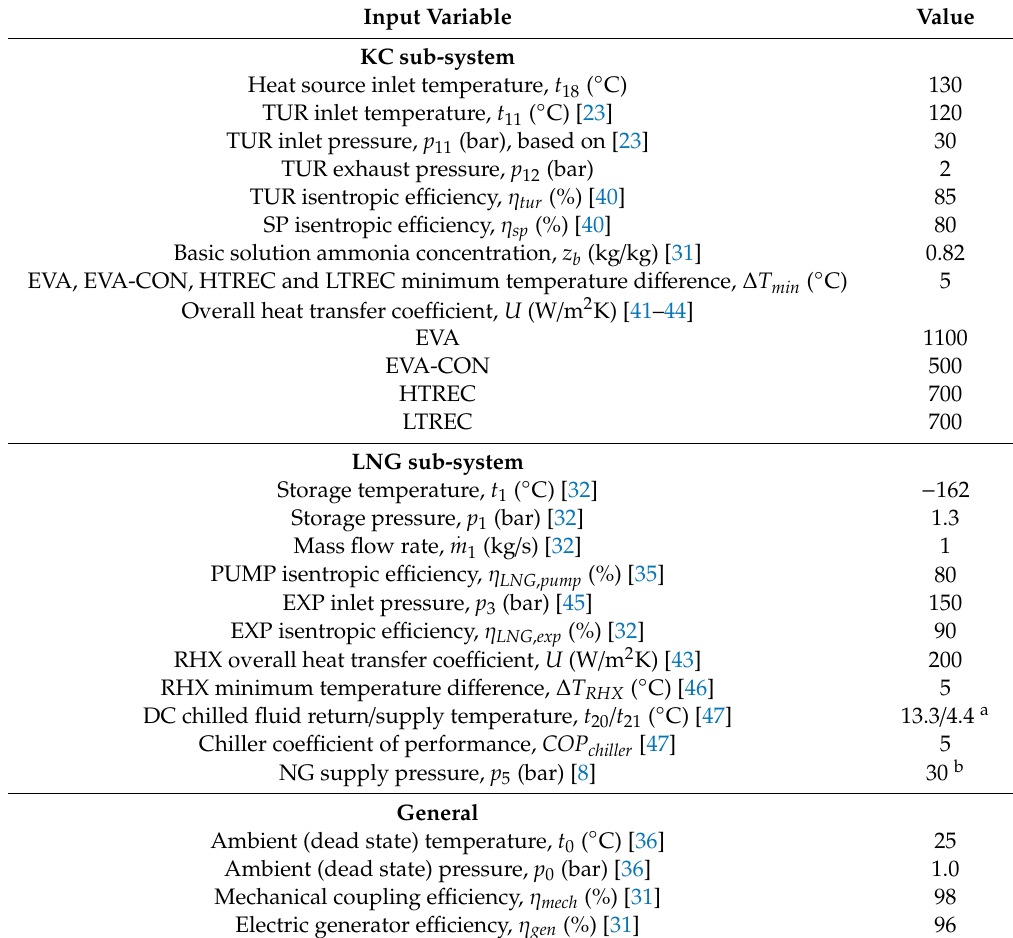
Table 1. Input modeling parameters for the KC-based poly-generation system at nominal conditions. Input Variable Value KC sub-system Heat source inlet temperature, t 18 ( ◦ C) 130 TUR inlet temperature, t 11 ( ◦ C) [23] 120 TUR inlet pressure, p 11 (bar), based on [23] 30 TUR exhaust pressure, p 12 (bar) TUR isentropic e ffi ciency, η tur (%) [40] 85 SP isentropic e ffi ciency, η sp (%) [40] 80 Basic solution ammonia concentration, z b (kg / kg) [31] 0.82 EVA, EVA-CON, HTREC and LTREC minimum temperature di ff erence, ∆ T min ( ◦